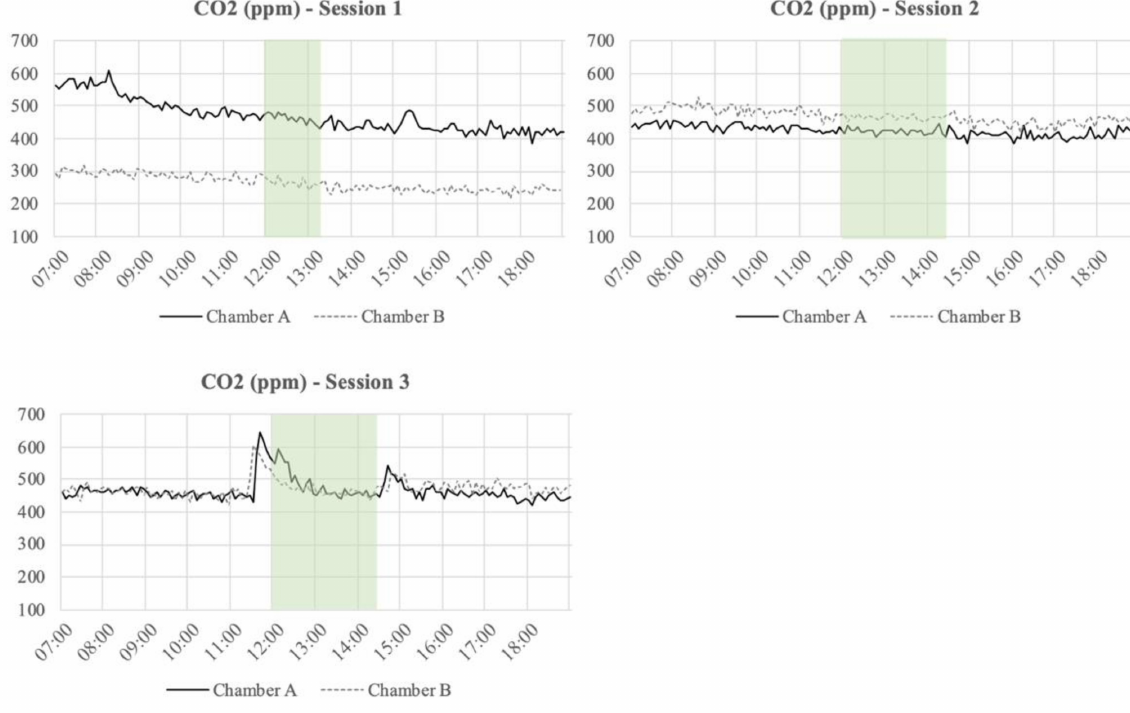
Figure 7. CO 2 levels (ppm) measured during the three sessions from 7.00 to 19.00 every 5 min. The highlighted section is the period when the participants executed the experiment and filled the